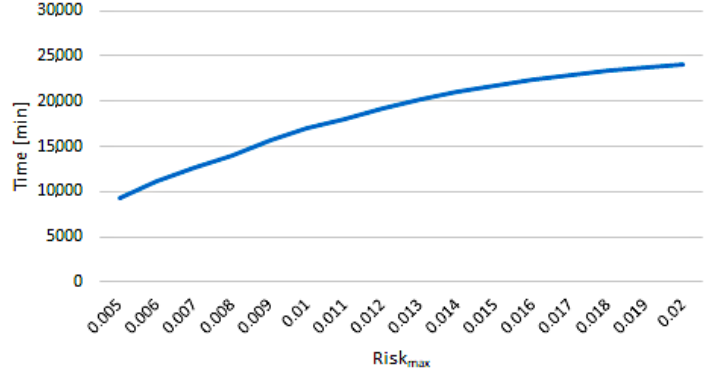
Figure 8. Time gained caused by the usage of the system.